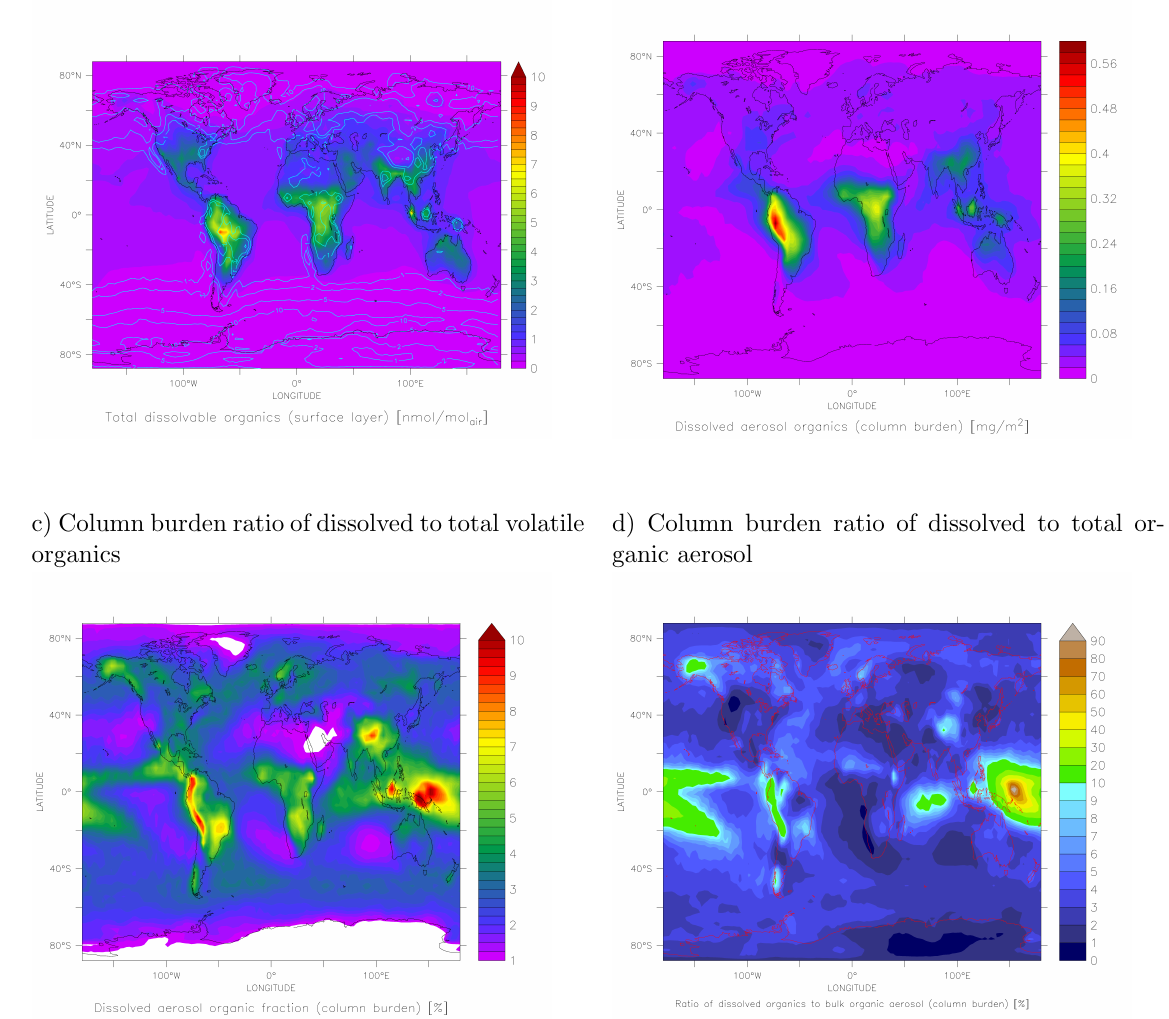
Fig. 7. Panel (a) shows the annual averages of the surface mixing ratio of dissolved volatile organics, namely the sum of HCHO, HCOOH and CH 3 COOH in nmol/mol. The turquoise contour lines represent the relative fraction to the total available sum of those compounds. (b) shows the dissolved organic column burden in mgm − 2 . (c) displays the percentage fraction of the total column burden of the sum of the three compounds, whereas in (d) the contribution of the dissolved material to the total organic aerosol (OC and the aged components) is presented. Note the different color bars and sometimes non-linear